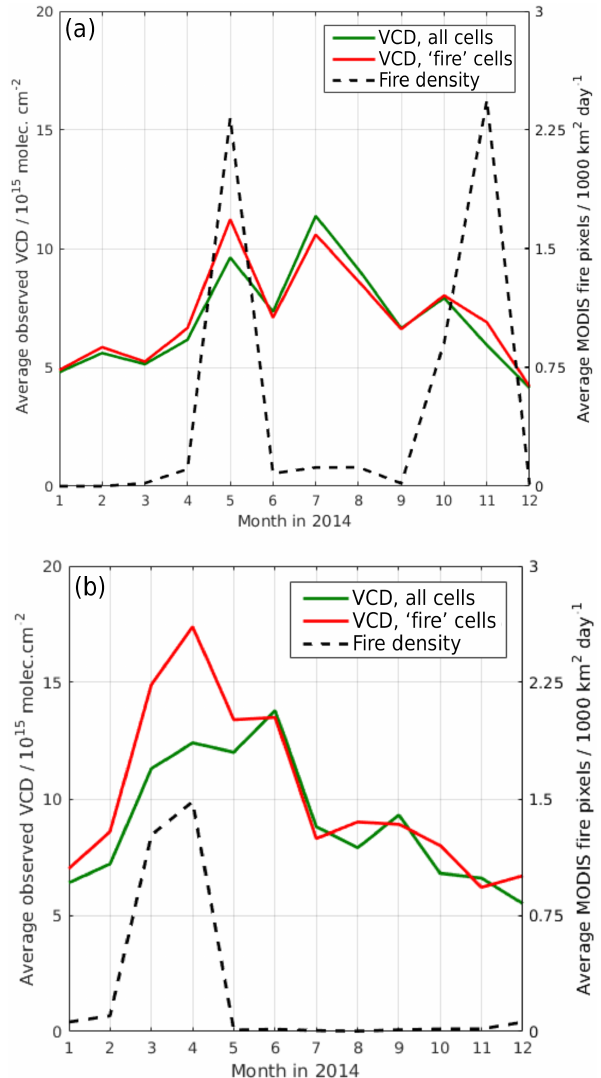
Figure 11. Time series of monthly mean HCHO columns (10 15 moleccm − 2 ) and the number of MODIS fire detections (10 3 km 2 day − 1 ) over (a) the states of Punjab and Haryana and (b) northeastern India. The green line denotes all HCHO columns over the region, and the red line denotes columns that are most affected by fires as indicated by MODIS fire